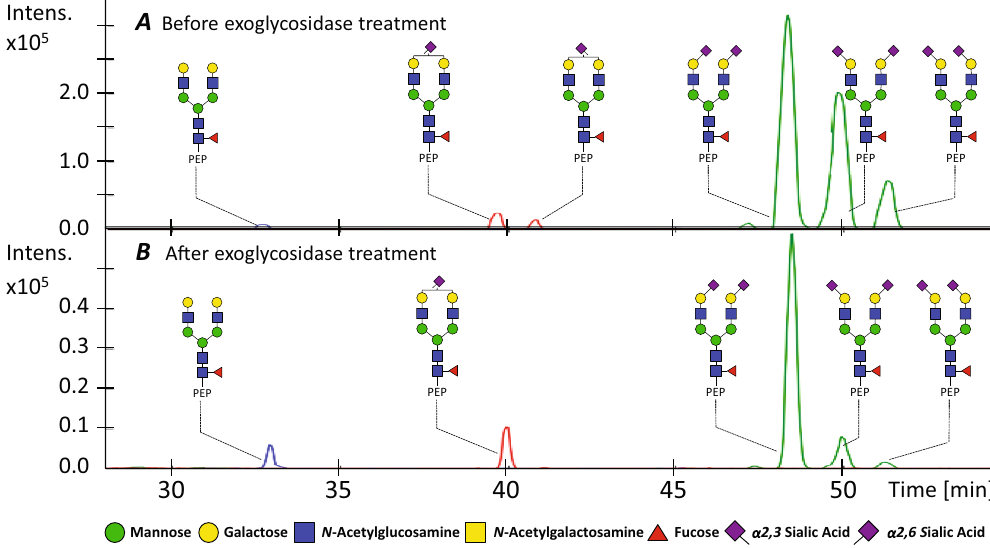
Figure 4. CE–ESI-MS analysis of PSA with and without α 2,3-sialidase treatment using CE–ESI-MS after targeted alignment. ( A ) EIEs of the non-sialylated glycopeptide (H5N4F1), the mono-sialylated glycopeptides (H5N4F1S1) and the di-sialylated glycopeptides (H5N4F1S2) of PSA prior to exoglycosidase treatment and ( B ) after exoglycosidase